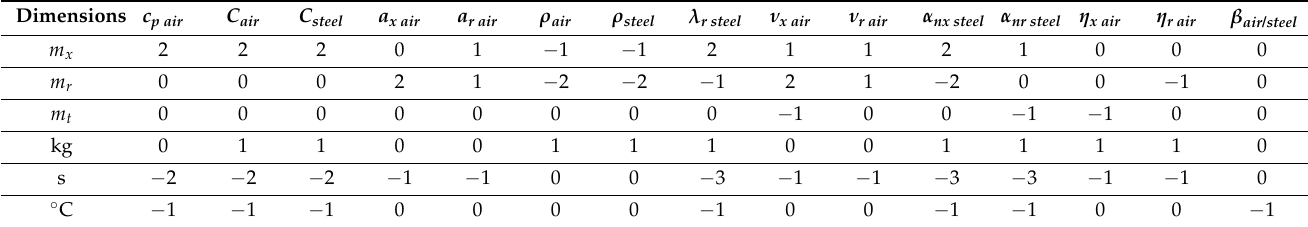
Table 4. The quantities required by the theoretic analysis (part of matrix B).